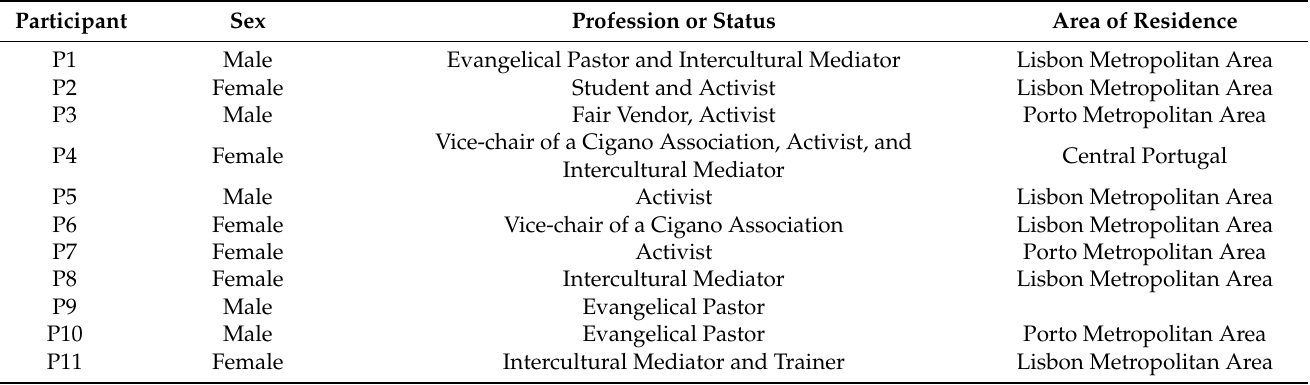
Table 2. Sociodemographic and professional characteristics of the Focus Group 2